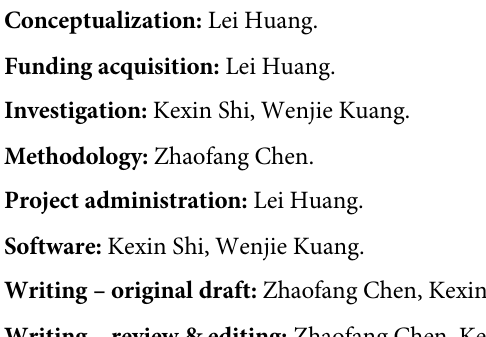
S2 Fig. The concentration of serum BUN (C) and Cr (D) in different groups. (DOCX) S3 Fig. The activity of GSH-Px, SOD and CAT and the content of GSH and MDA of liver in different groups. S4 Fig. The activity of GSH-Px, SOD and CAT and the content of GSH and MDA of kidney in different groups. S5 Fig. The pathological scores of liver and kidney in different groups. S6 Fig. The pathological sections of liver in different groups. S7 Fig. The pathological sections of kidney in different groups. S8 Fig. The interaction effect of treatments and sexes contributed to serum BUN. S1 Table. Dose of cadmium in the feed of different experimental groups. S2 Table. Liver and kidney indexes in different groups. (DOCX) S3 Table. The tests of between-subjects effects in different dependent variables. (DOCX) S4 Table. The descriptive statistics of the kidney index and MDA of kidney.